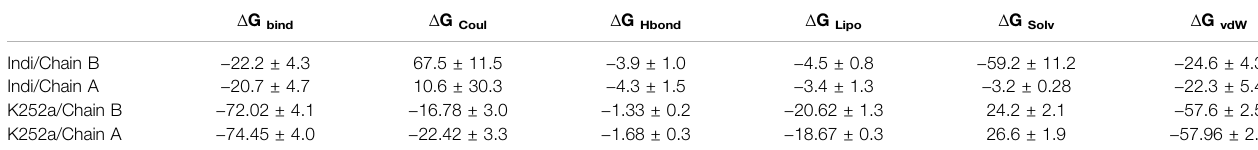
TABLE 2 | Predicted MM-GBSA free energies (kcal/mol) and individual energy terms of the Indicaxanthin-target complexes and K252a-target complexes.